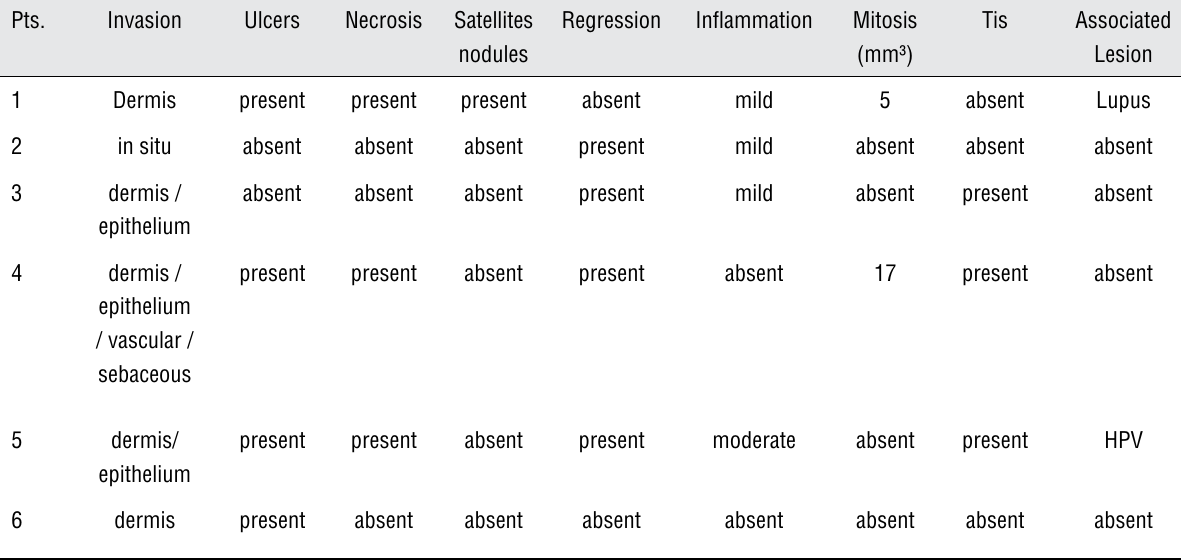
Table 2 - Histological characteristics of the tumors.